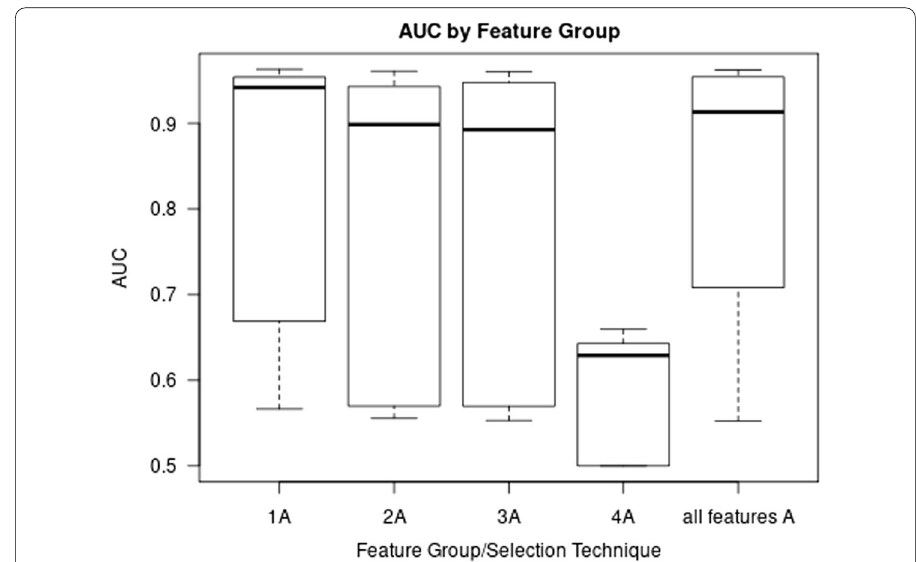
Fig. 2 Box plots of AUC grouped by feature group/selection technique; here datasets do not include destination port; Tukey’s HSD test indicates feature groups/selection techniques 1A, all features A in group a,